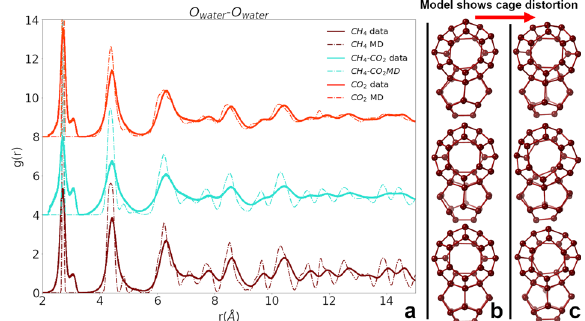
Fig. 2 Host – host RDFs. a RDFs calculated from MD simulations (dashed lines) and RMC fi ts to neutron data (solid) for the O water – O water pair distances for observing the impact of guest molecule on cage distortion. b A large and small cage pair before RMC and c after RMC fi t to data showing distortion in the cages as observed with neutron PDF data. The distortion of the cages is the most extreme for the mixed guest hydrate (middle row).